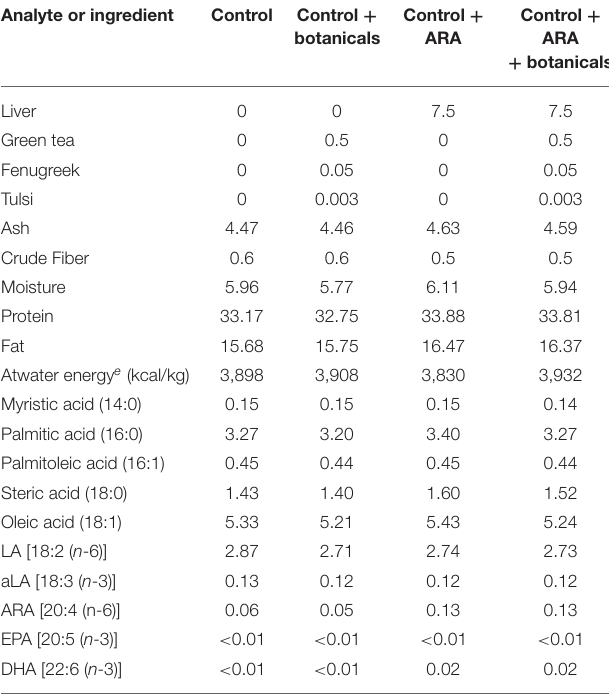
TABLE 1 | Food composition (grams/100g as fed unless otherwise stated). Analyte or ingredient Control Control +